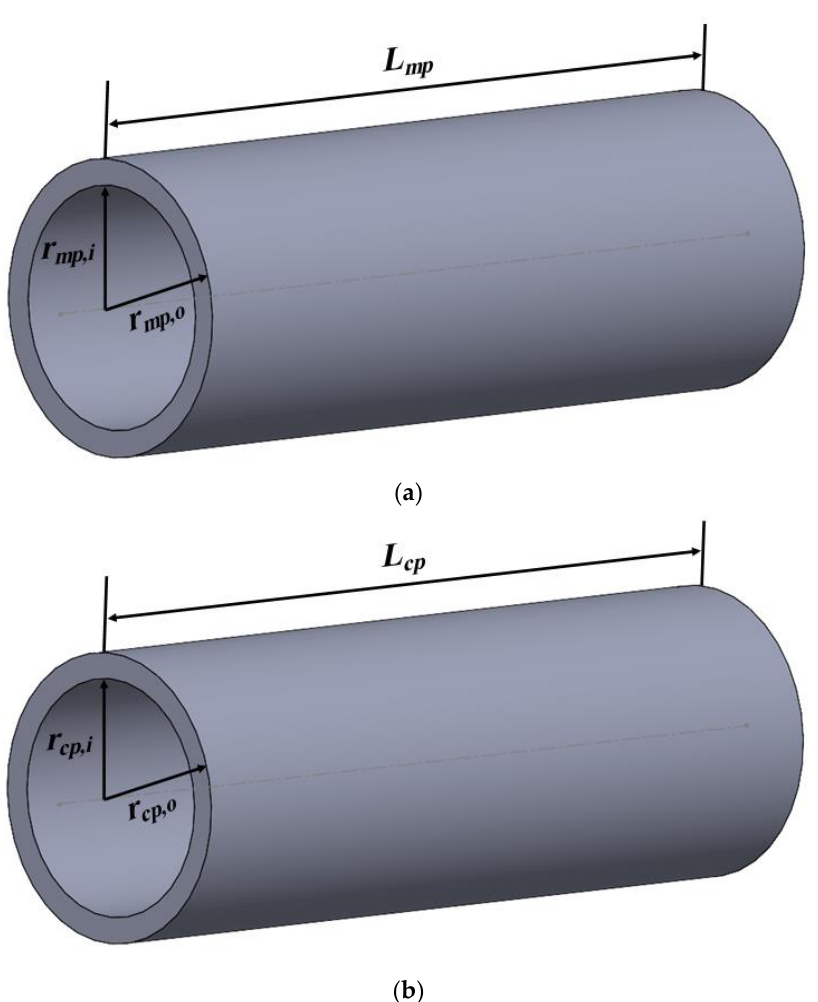
Figure 1. Proposed system.